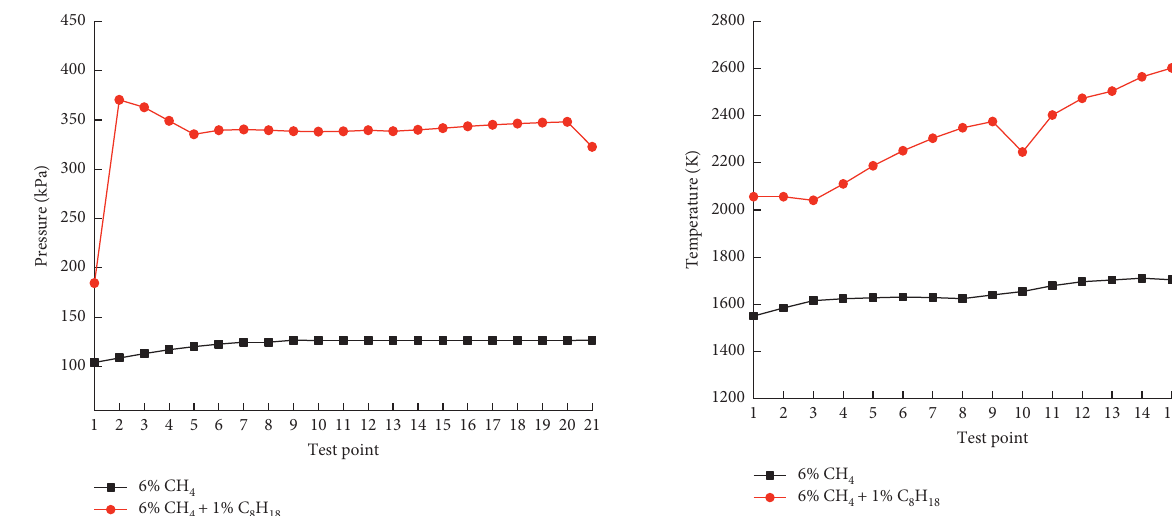
Figure 15: Curves of peak temperature under different gas